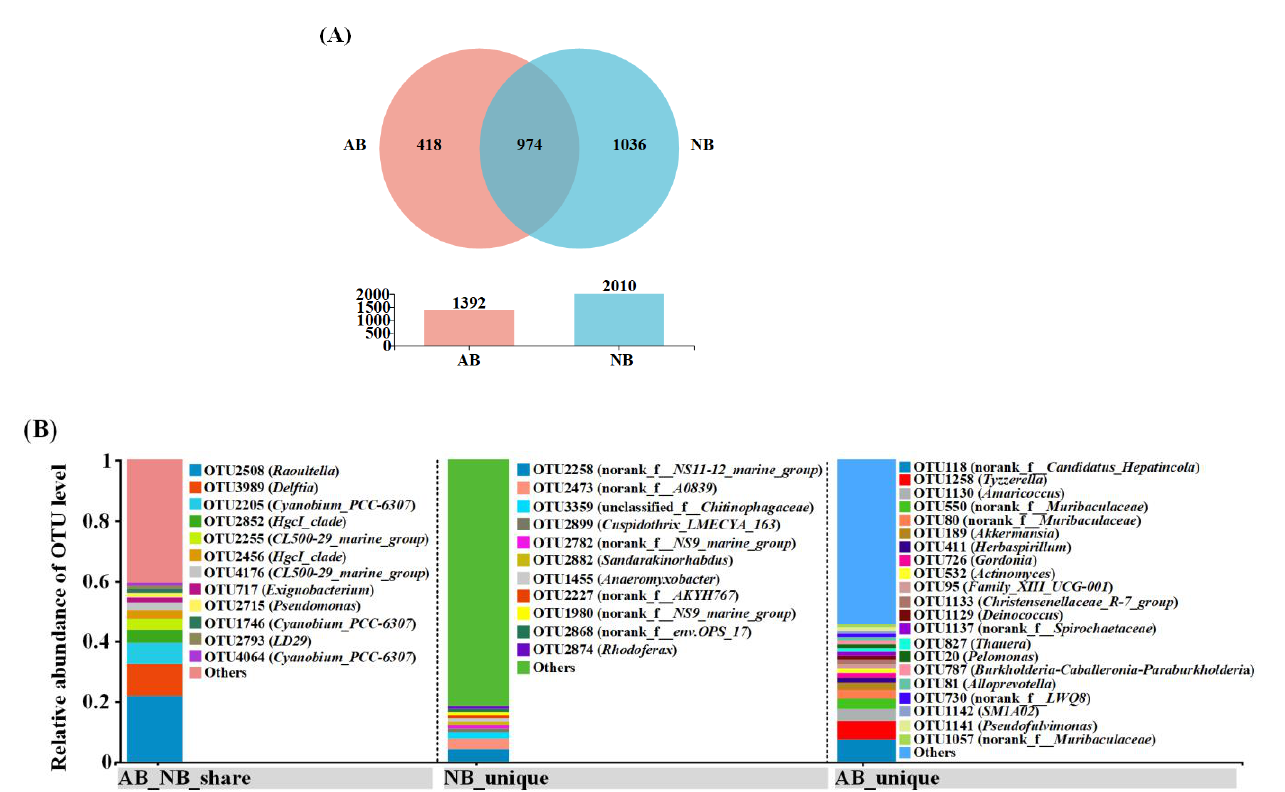
Figure 4. Distribution and quantity of unique or shared OTUs in B. calyciflorus -associated bacterial and bacterioplankton communities. ( A ) The number of unique or shared OTUs. ( B ) Distribution of unique and shared OTUs.